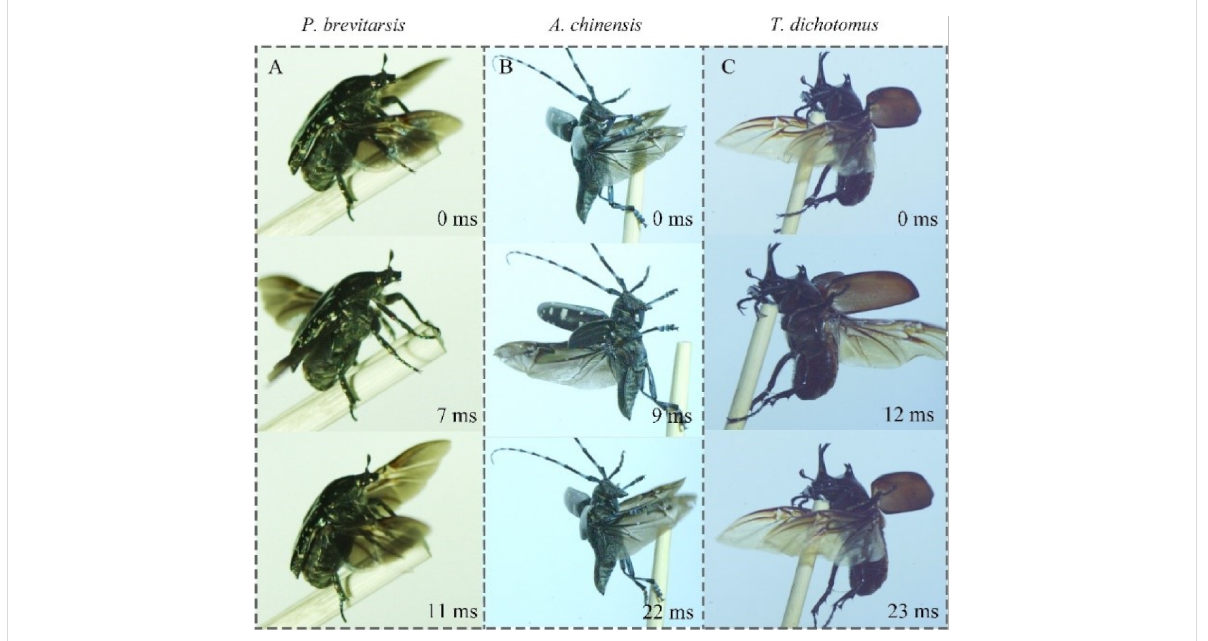
Figure 2: (A), (B), and (C) show one flapping cycle of P. brevitarsis , A. chinensis , and T. dichotomus , respectively.